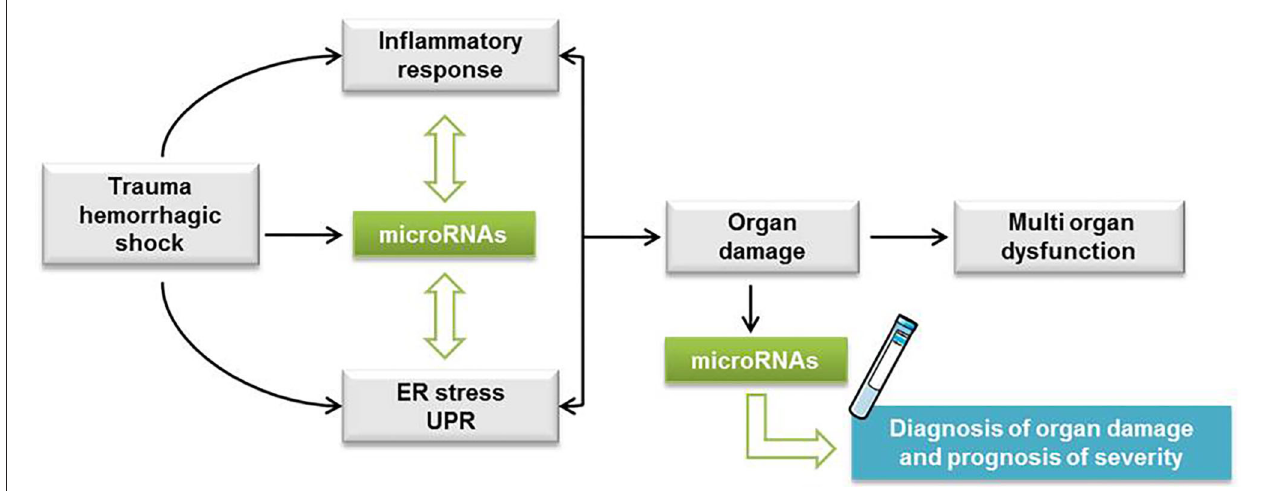
FIGURE 5 | Hypothetic scheme with the interplay between ER stress and miRNAs upon THS. Cellular perturbations resulting from trauma hemorrhagic shock (THS) activate inflammation and endoplasmic reticulum (ER) stress which triggers the unfolded protein response (UPR). At the same time, THS also induces the release of miRNAs in the plasma that fine-tune ER stress/UPR and inflammatory response. The feed-forward loop comprising the activation of inflammation and ER stress is implicated in the development of cell damage followed by single and multiple organ